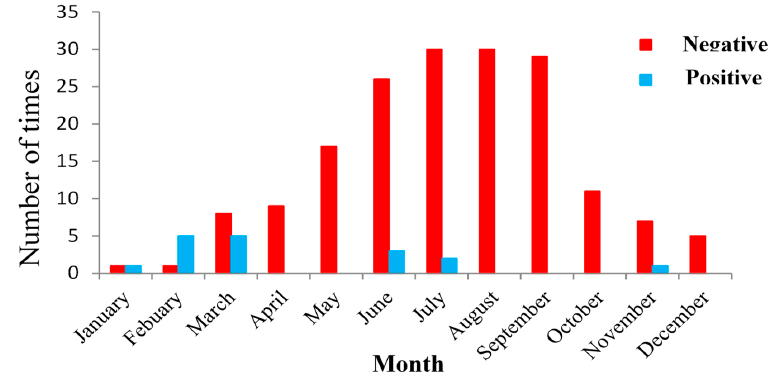
Table 7. Human-modified drought characteristics.